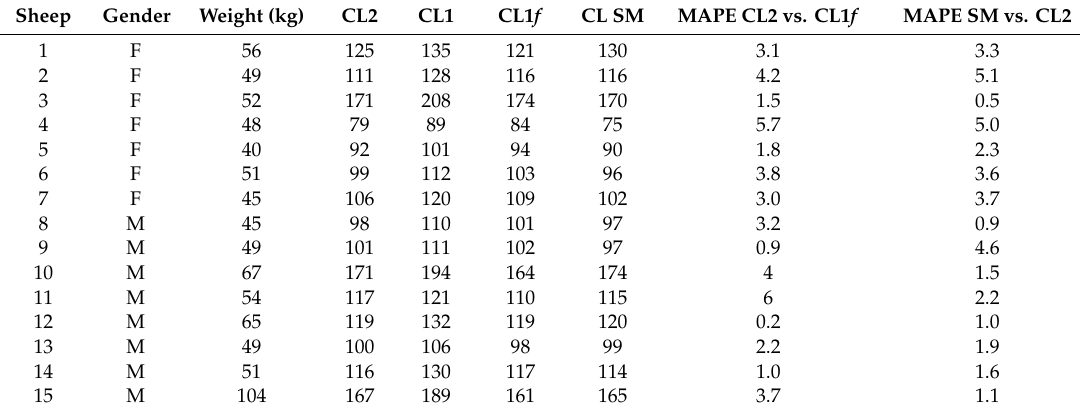
Table 1. Iohexol plasma clearance in the one (CL1; CL1 f ) and two-compartment models (CL2). SM = simplified method based on CL2. CL1 f : CL1 with the adjustment formula. MAPE = mean absolute percentage